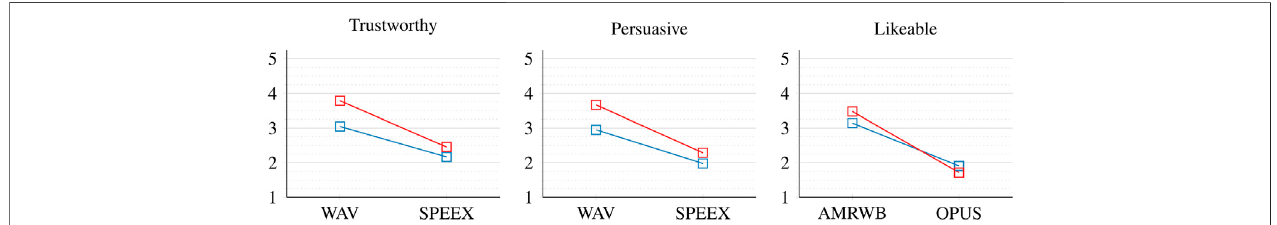
FIGURE 1 | Changes of selected perceived charisma related attributes for men () and women (Fx2).